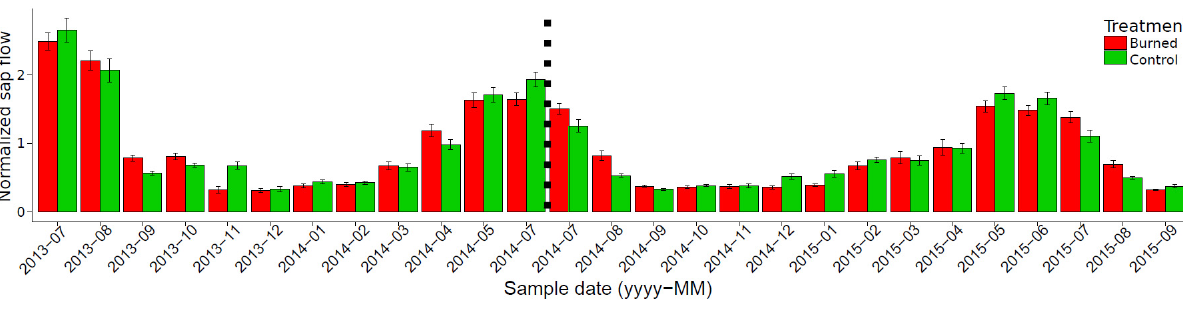
Figure 6. Normalized sap flow for control and burned trees. The histograms represent the average value per month of the daily flow, normalized by the average pre-burning value. Error bars represent the standard error. The dashed vertical line represents the prescribed burn.